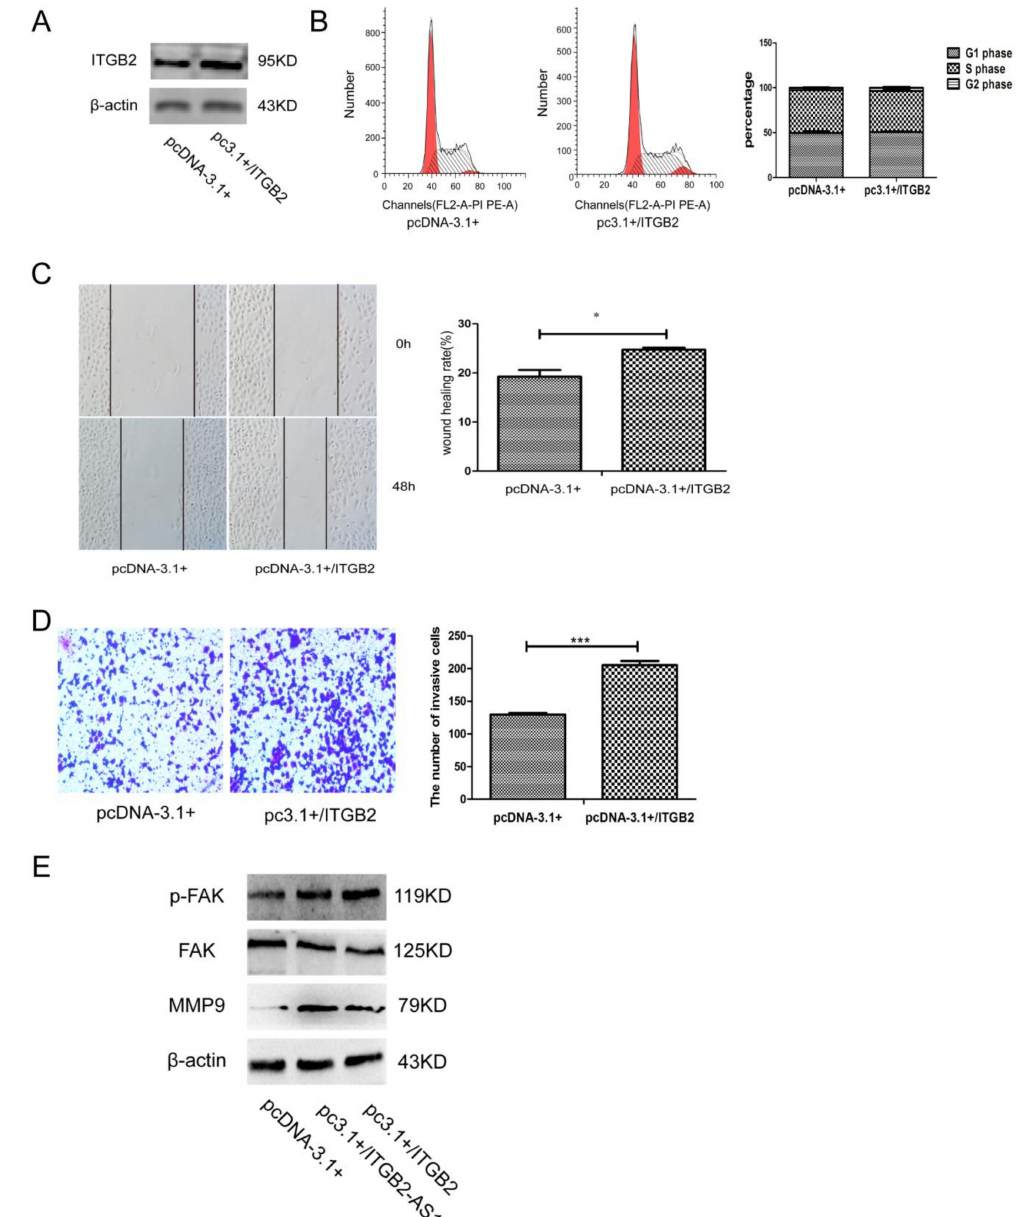
Figure 5. Overexpression of ITGB2 also could facilitate the migration and invasion of MCF-7 cell. ( A ) The verification of ITGB2 plasmid with western blotting assay; the β -actin was used as internal reference; ( B ) The cell cycle was evaluated by flow cytometry. Left panel: X-axis: cell number; Y-axis: DNA content; ( C )The migration was detected by wound healing assay; ( D ) The cell invasion measured by transwell chamber assay, stained by 0.1% crystal violet (400 × ); ( E ) The detection of FAK signaling and MMP9 protein by western blotting assay. * p < 0.05, *** p < 0.001 vs. control